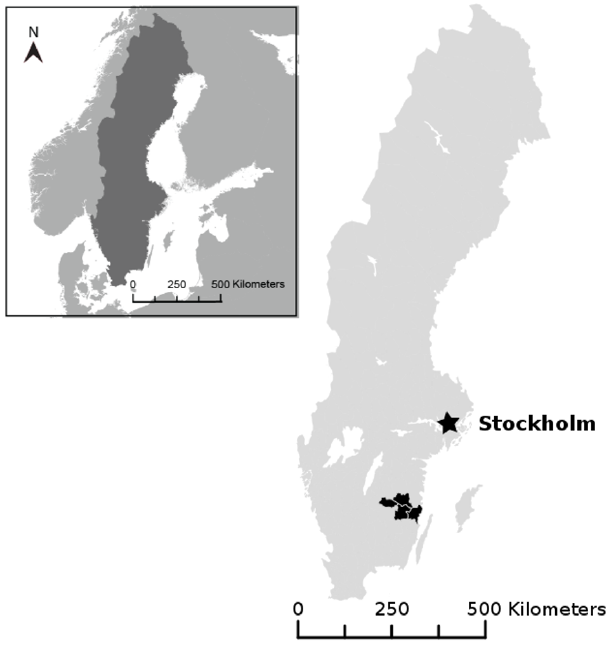
Fig. 2 . Map of the case study area in Southern Sweden. The LEADER region where the collaboration project took place included four municipalities: Eksjö, Hultsfred, Oskarshamn, and Vimmerby. The region is largely rural and the biggest town has 17,000 inhabitants (SCB 2010). The landscape consists of a mix of forests and agricultural land, interspersed with several smaller